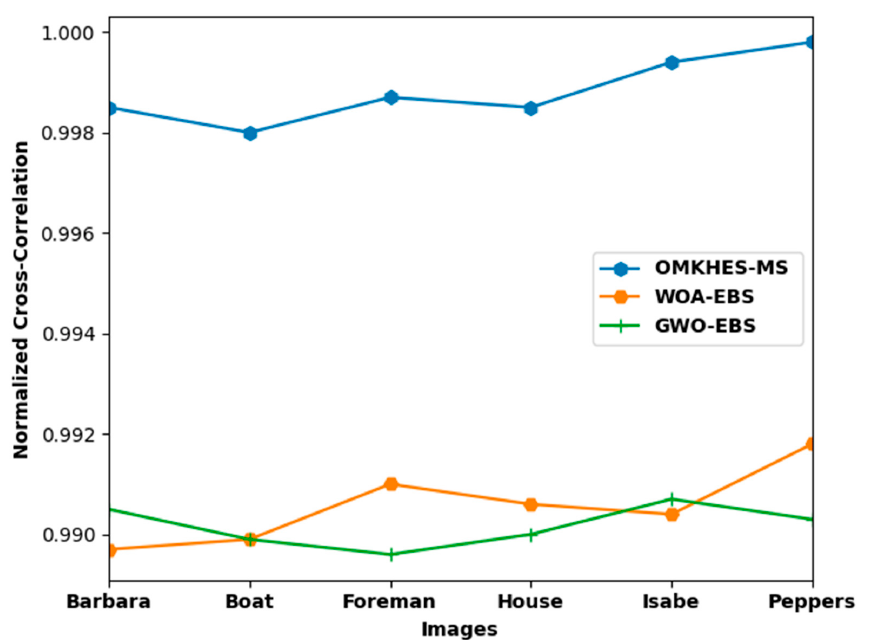
Figure 12. Comparative NCC analysis of OMKHES-MS technique with existing models.